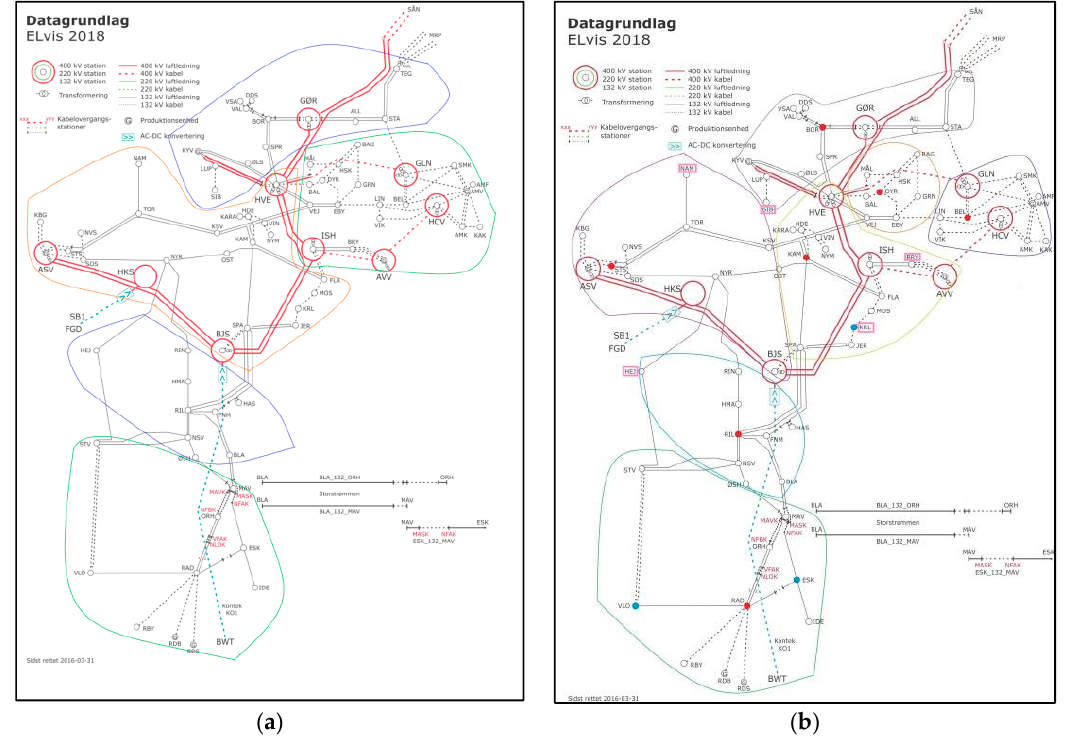
Figure 4. These are Figures of DK2: ( a ) Is DK2 divided in 5 Mvar zones, based on earlier Energinet analysis. ( b ) Is DK2 divided in 7 Mvar zones, based on the analysis for this paper.